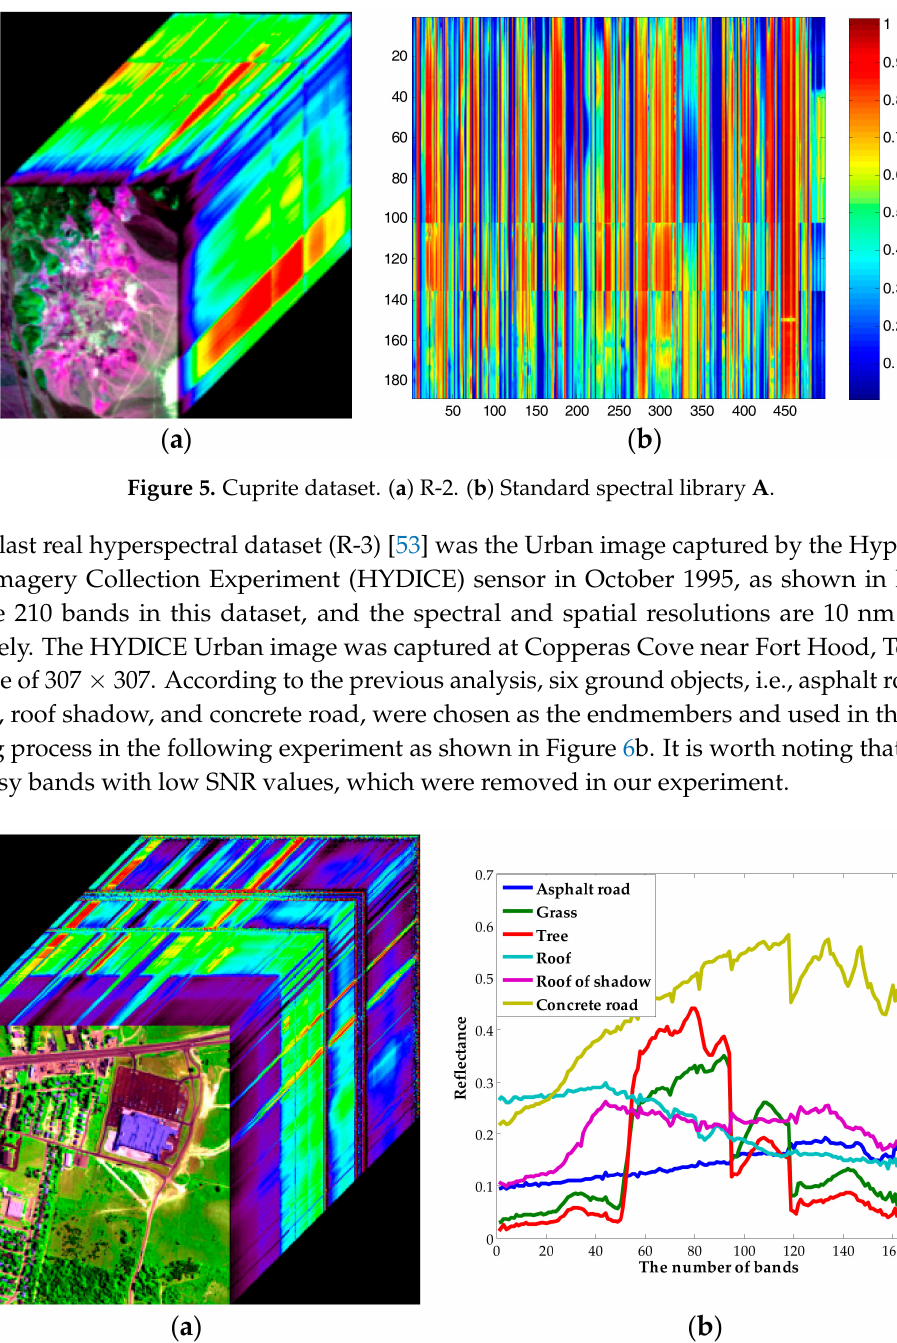
Figure 6. Hyperspectral Digital Imagery Collection Experiment (HYDICE) Urban image. ( a ) R-3. ( b ) Six endmember